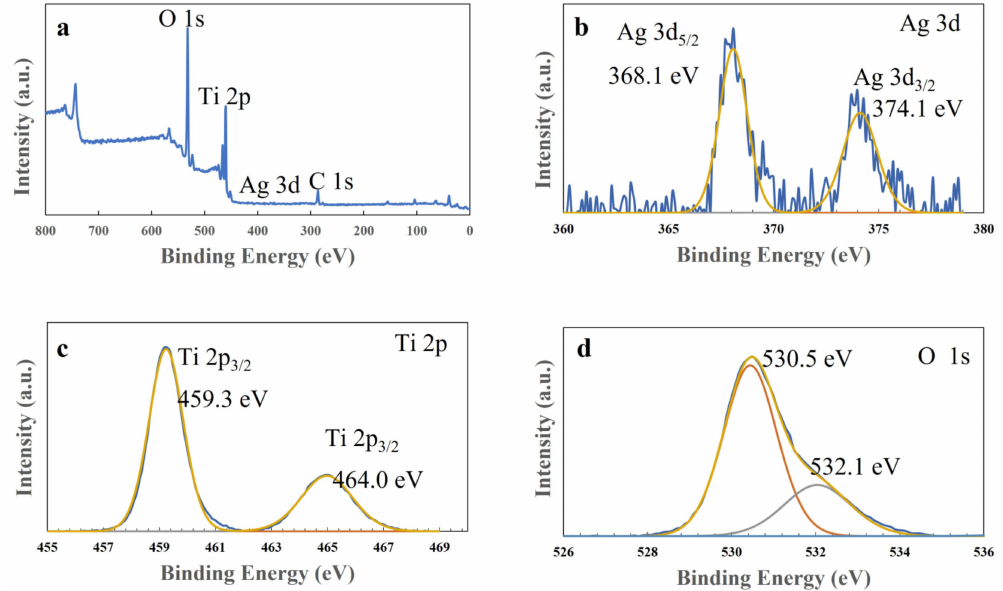
Figure 6. X-ray photoelectron spectra of the T-C-A0 film: ( a ) survey, ( b ) Ag 3d, ( c ) Ti 2p, and ( d ) O 1s